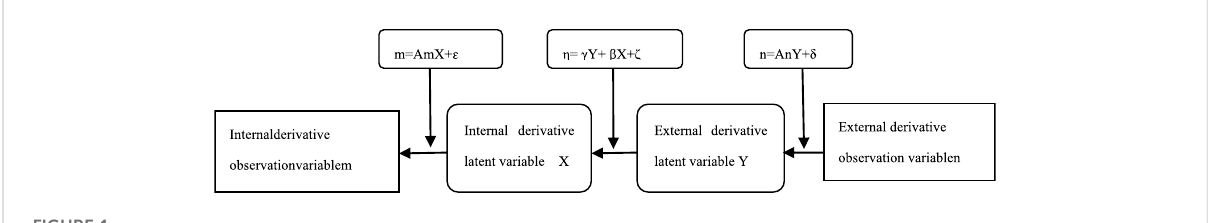
FIGURE 1 Structural equation model diagram (Figure source: by authors according to the connotation of